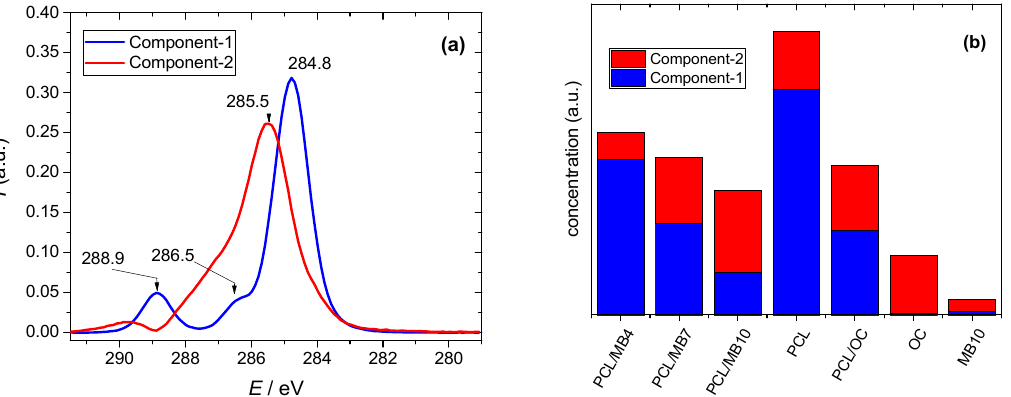
Figure 4. Spectra ( a ) and fractions ( b ) of the components calculated by multivariate curve resolution—alternating least squares of the X-ray photoelectron spectra in the C1s region.